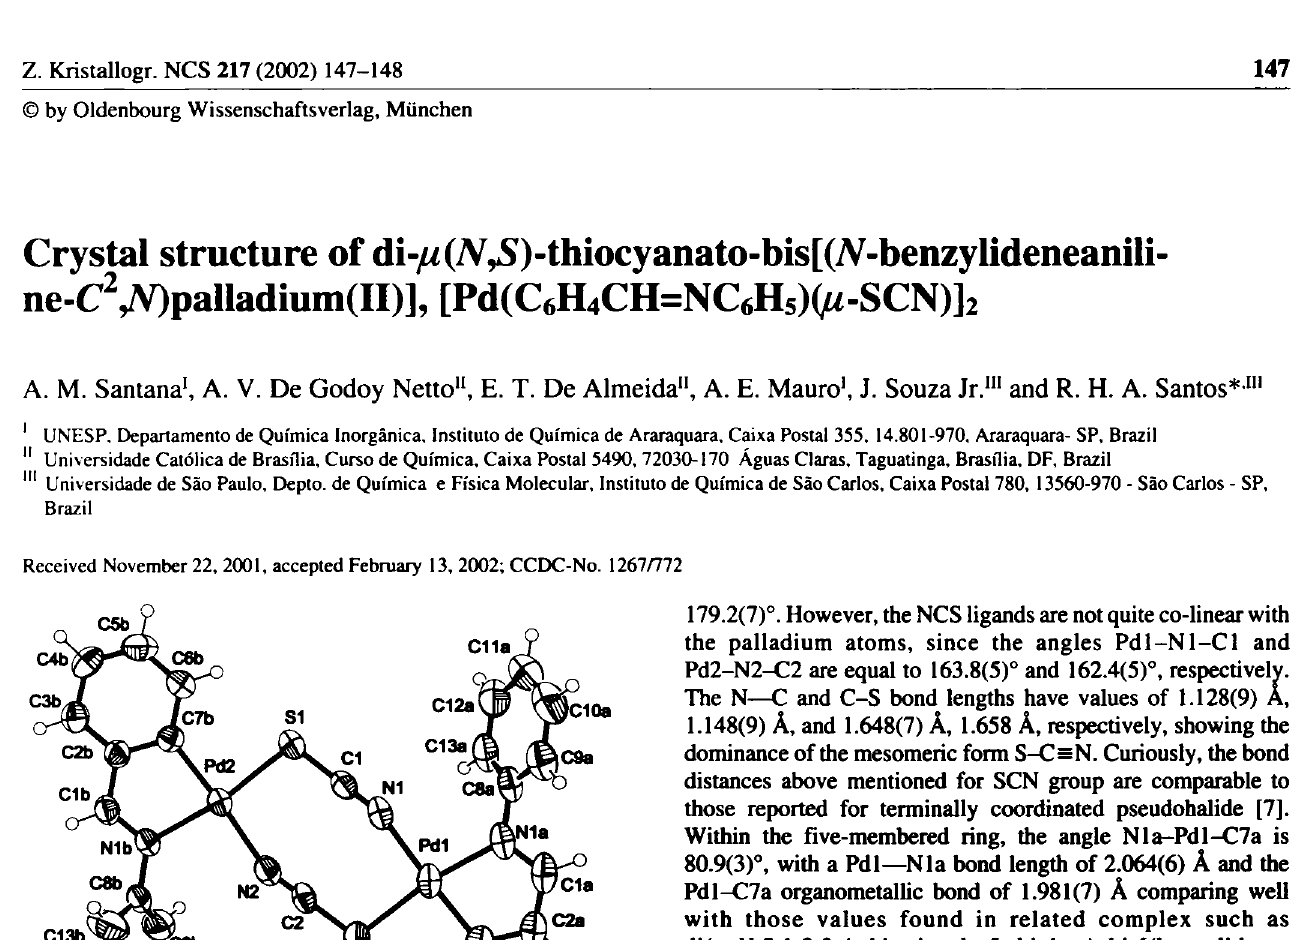
Table I. Data collection and handling.